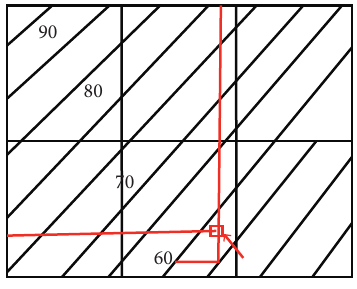
Figure 7: Schematic diagram of linear interpolation.